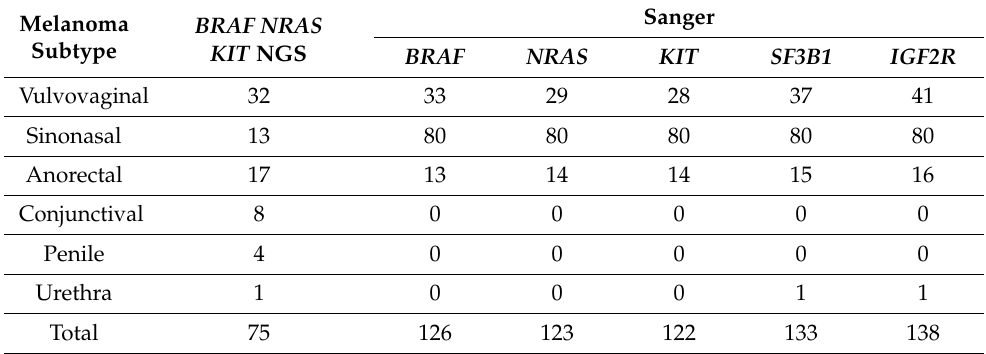
Table 1. Summary of cases analyzed by next generation sequencing (NGS) and Sanger